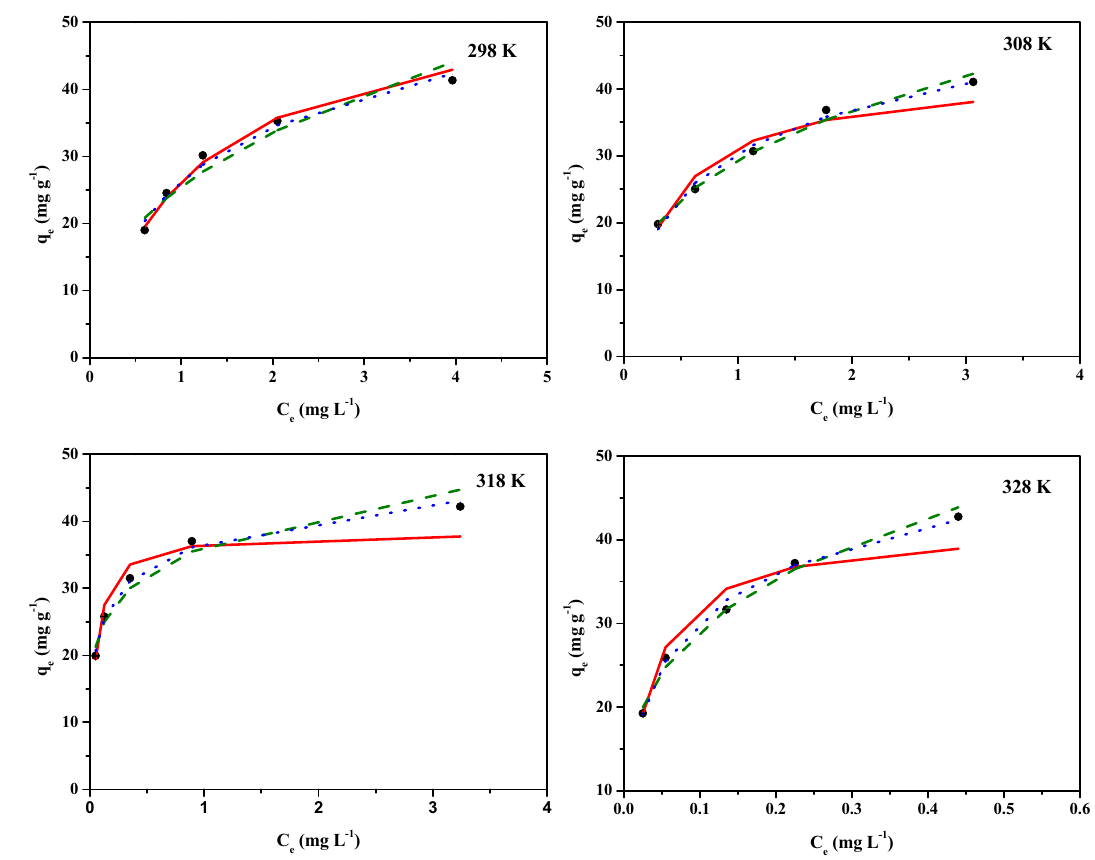
Figure 5. Adsorption isotherms of Pt(IV) on Tu–N–SCG–C–A at different temperatures (298–328 K). Operating conditions: 250 mg of biocarbons and 50 mL of 50 mg L −1 Pt(IV) solution, pH = 2) (red solid line: